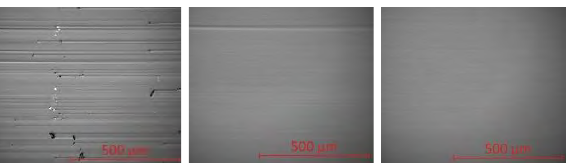
Fig . 8 . Microscopic view in depths 25 µm, 50 µm and 75 µm respectively of the V-shape polished surface grinded with the D151 tool.